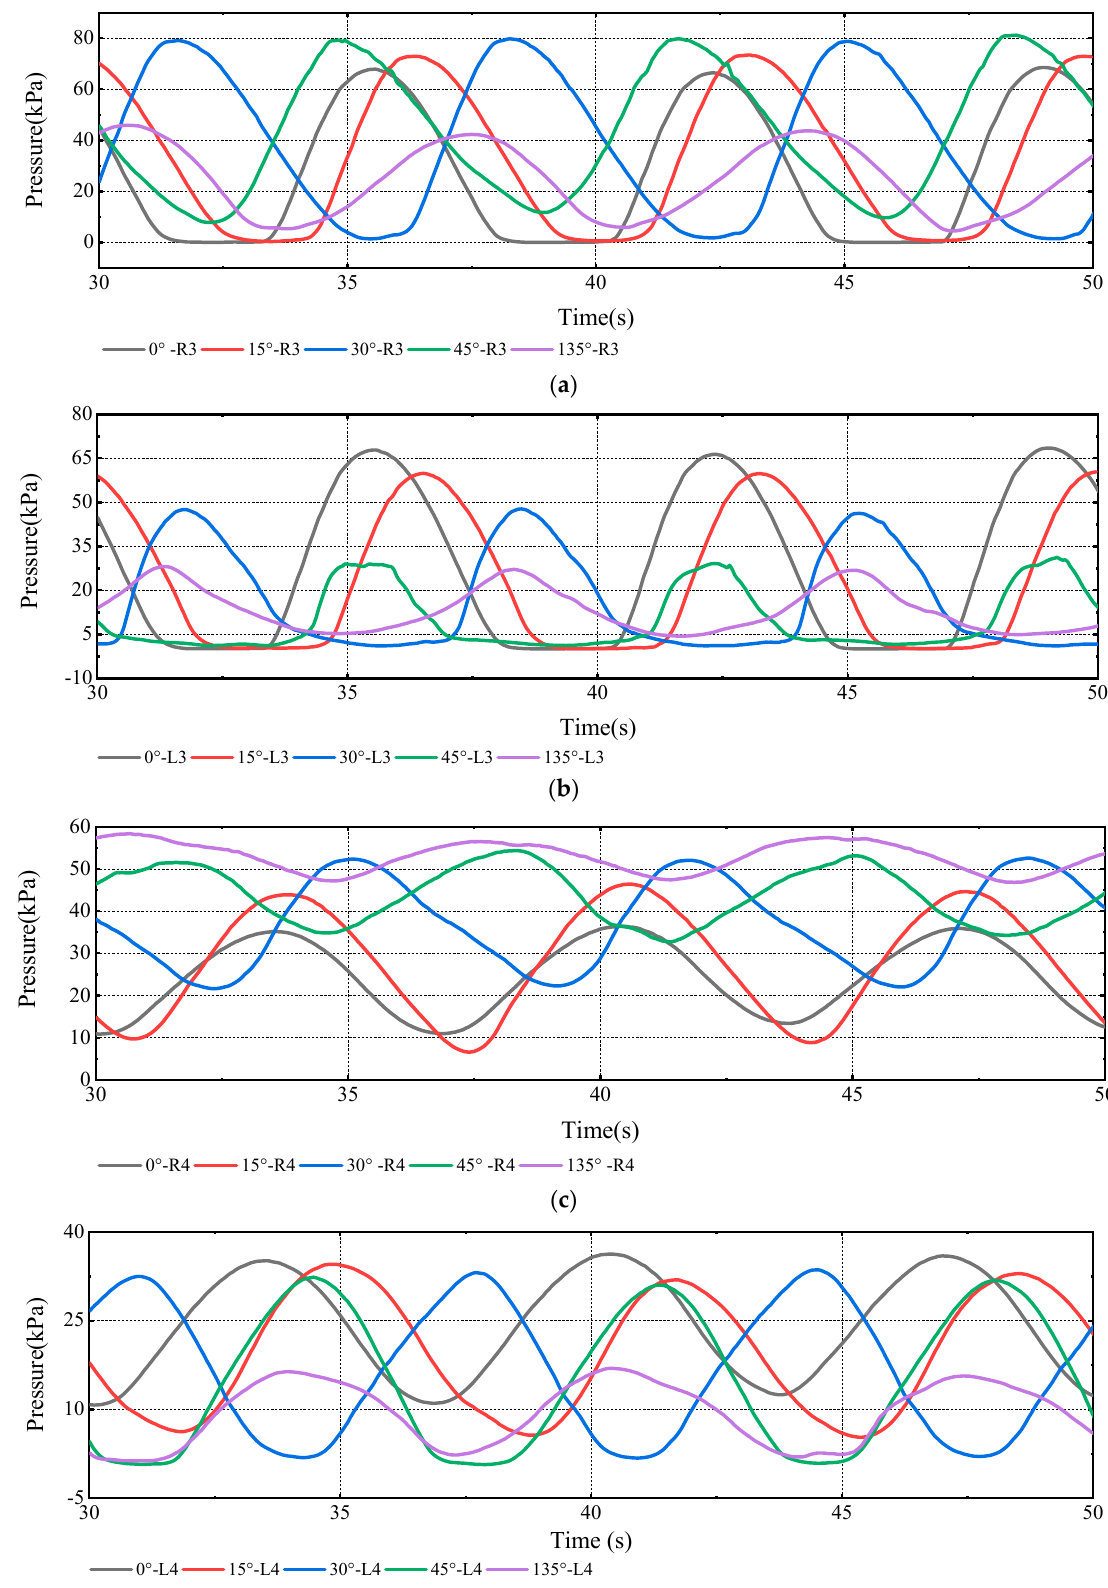
Figure 17. Time histories of slamming pressure corresponding to different wave headings. ( a ) Starboard side of main hull; ( b ) Port side of main hull; ( c ) Right-side hull; ( d ) Left-side hull.